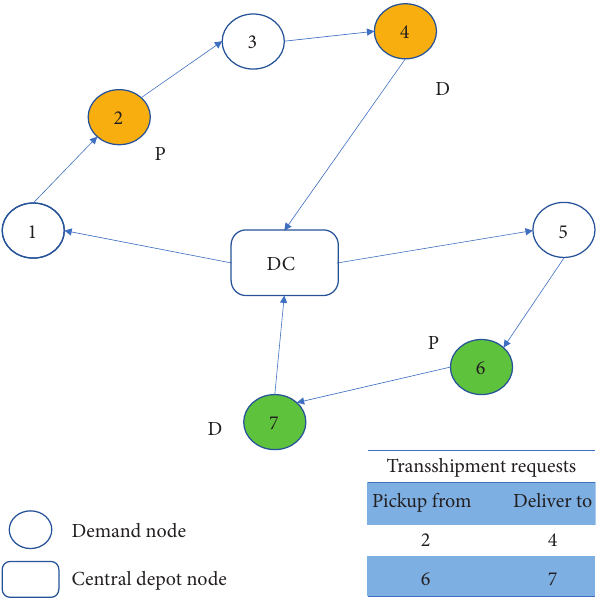
Figure 1: Vehicle routing problem with transshipment